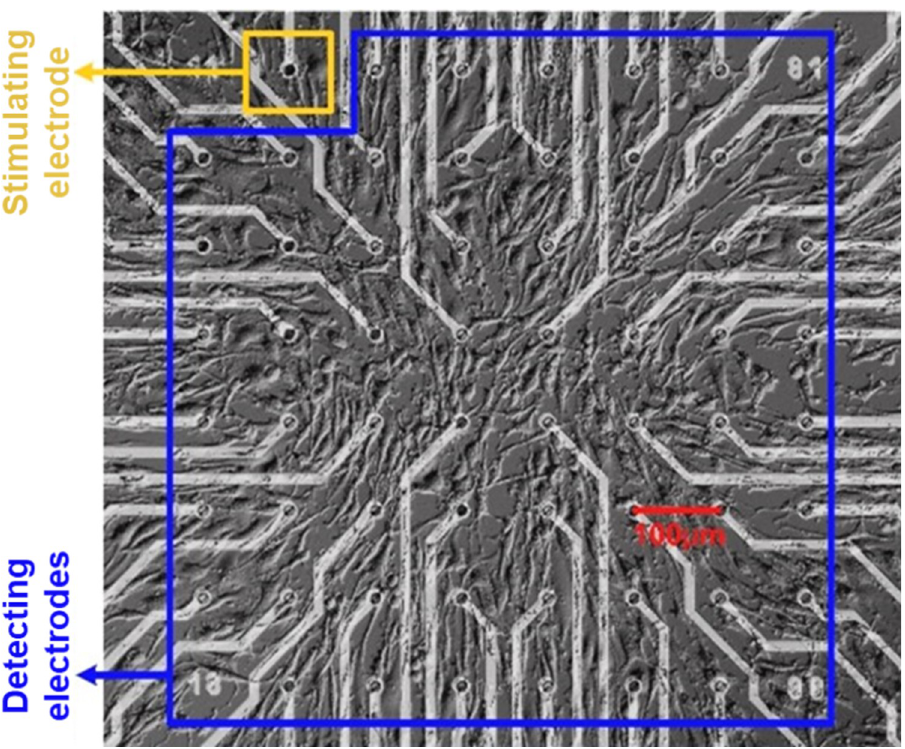
Fig 1. The status of PC12 quasi-neuronal networks on MEA and the selection of stimulating electrode (in yellow box) and detecting electrodes (in blue box).